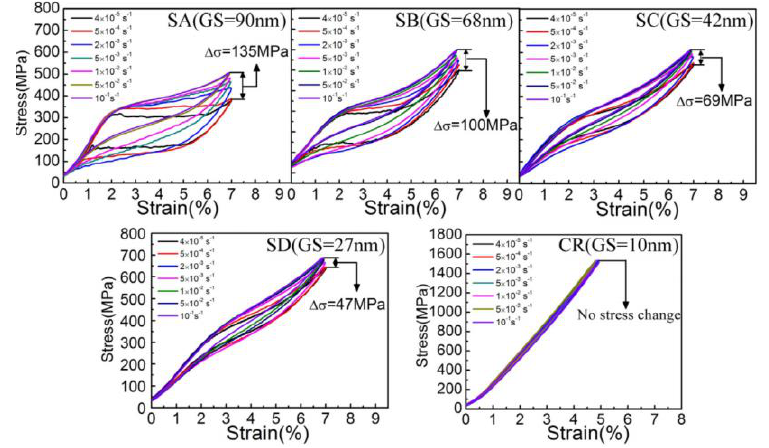
Figure 11. The effect of five Grain Sizes (GS) on the σ − ε curves under monotonic loading–unloading in the strain rate range from 4 × 10 − 5 s − 1 to 10 − 1 s − 1 [40]. (Reprinted from Ref. [40], Figure 5, 2014, with permission from Elsevier.)